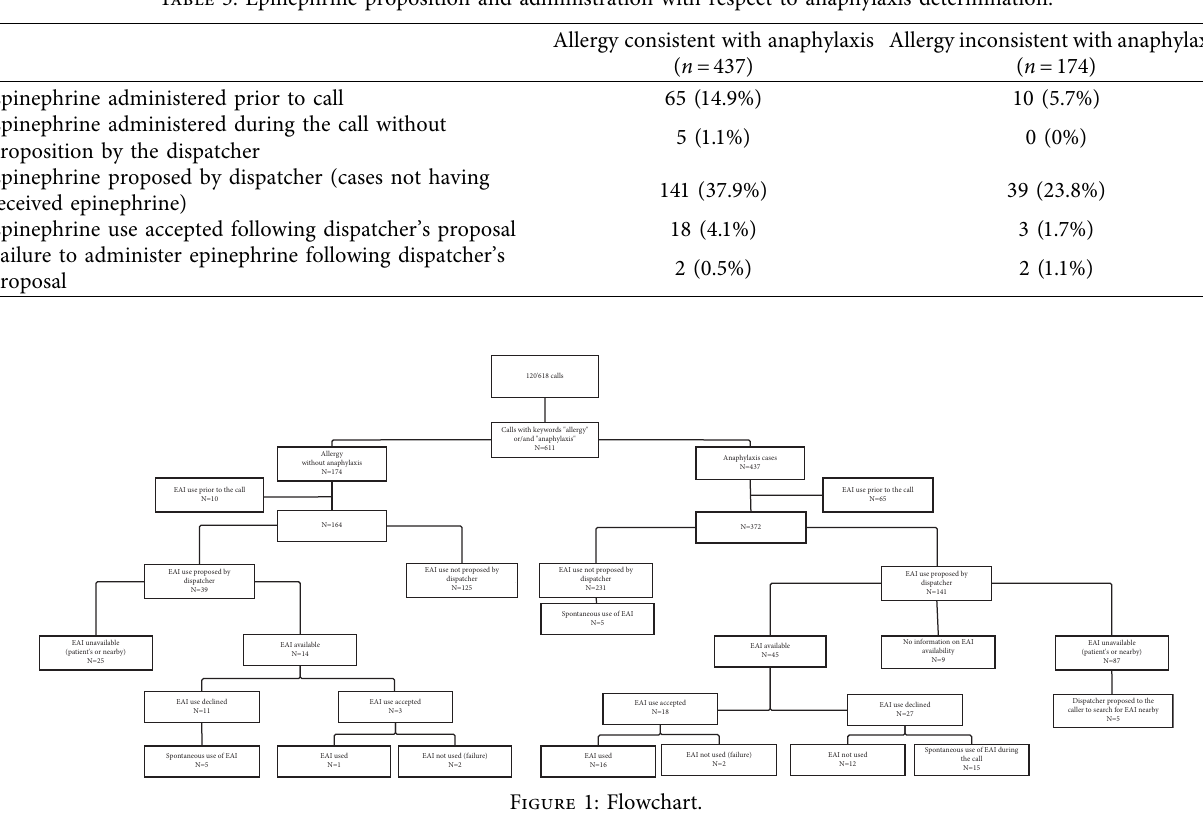
Table 3: Epinephrine proposition and administration with respect to anaphylaxis determination.